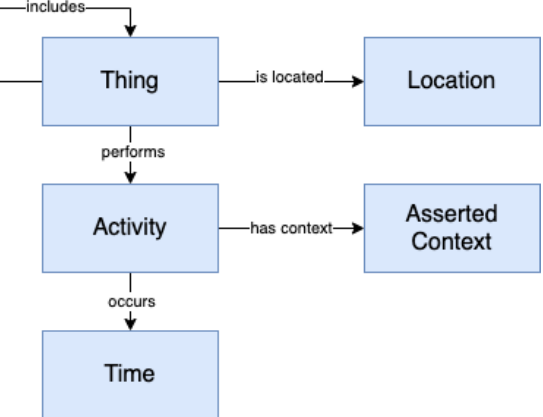
Figure 1. Relations among the five core classes of the